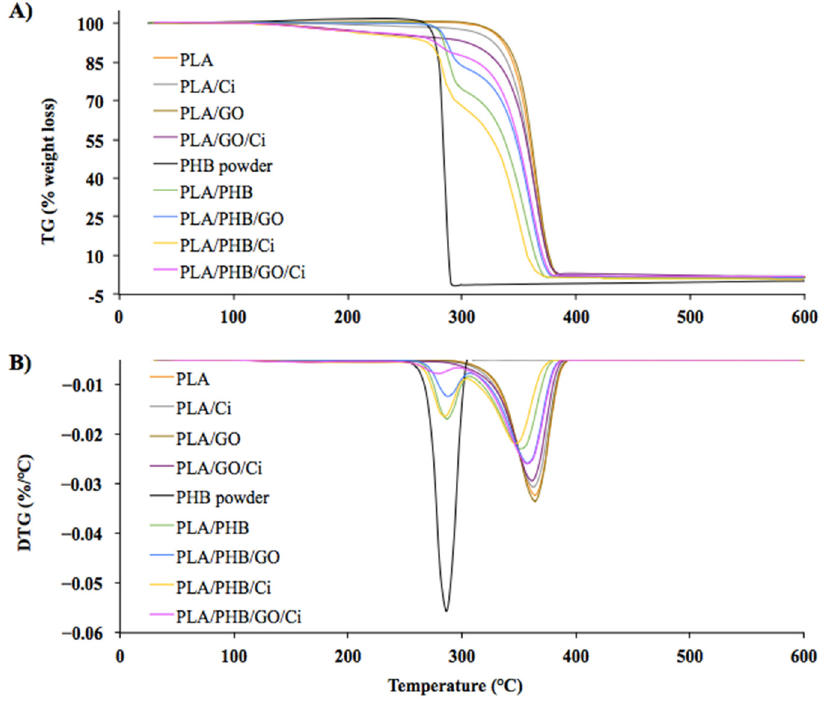
Figure 3. TG ( A ) and DTG ( B ) curves obtained for PLA, PHB, blends, and bionanocomposites.